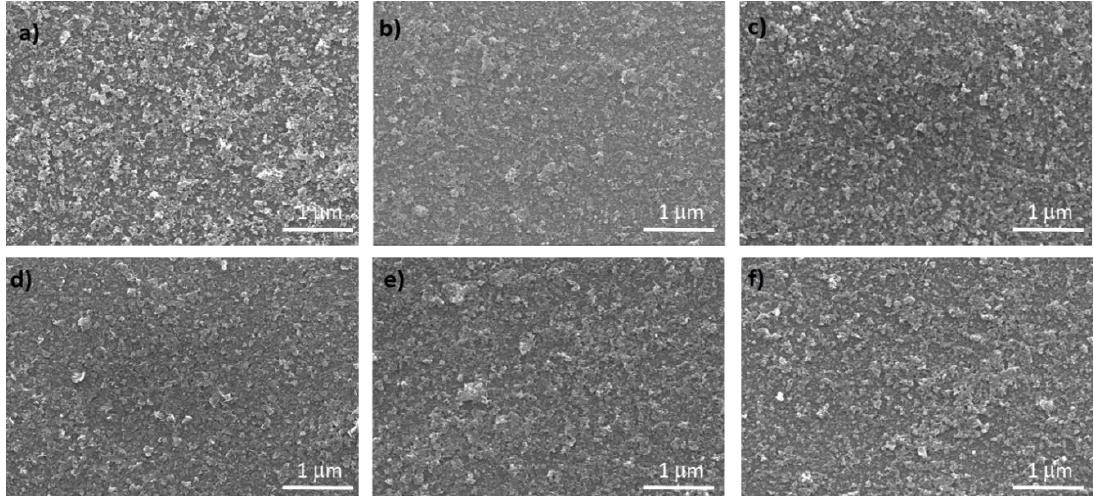
Figure 3. ( a ) X-ray diffraction (XRD) patterns of the NiO x and Co-doped NiO x nanoparticles; ( b ) optical transmission spectra for the NiO x and Co-NiO x films fabricated on top of ITO substrates, where the thickness of the Co-NiO x films was around 37 nm.